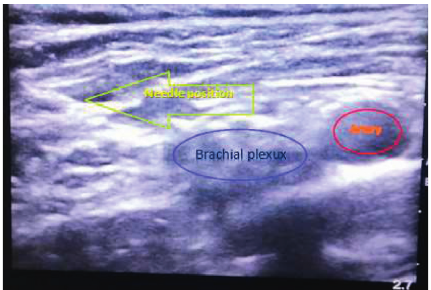
Figure 1: Needle position in the divisions of the brachial plexus seen as a bunch of grapes-like structures lateral and superficial to the subclavian artery.